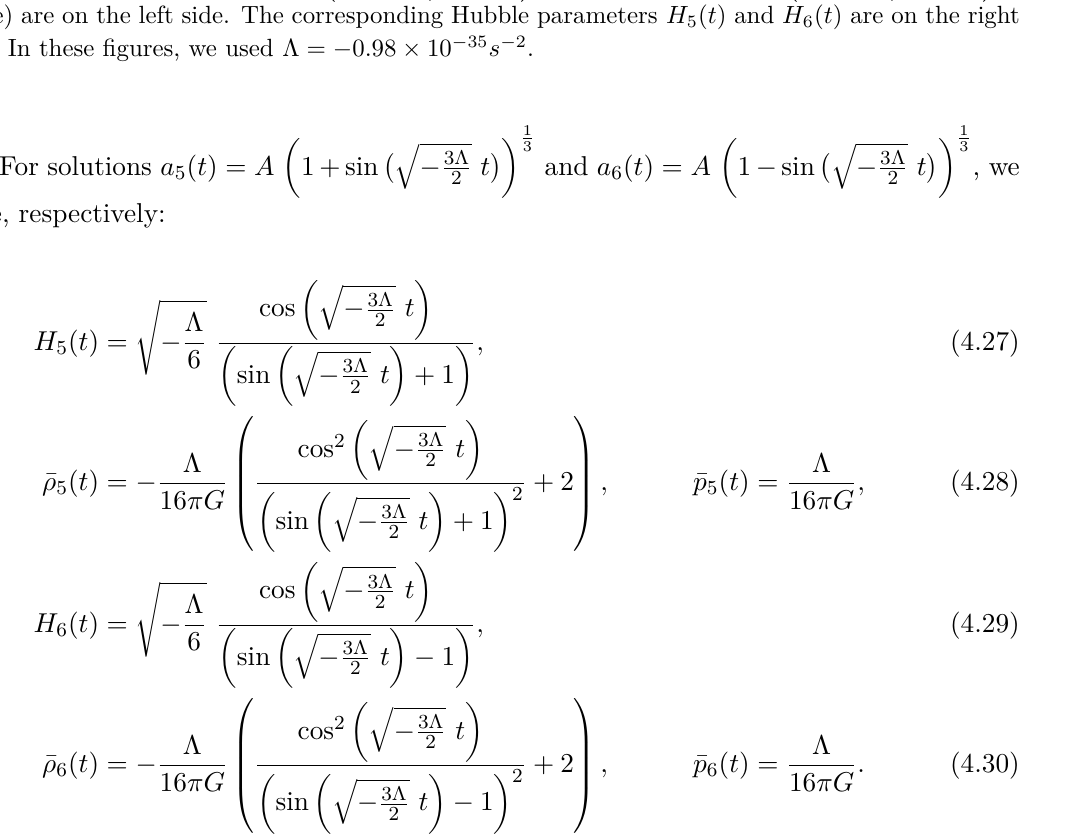
(cid:0)q (cid:16) (cid:1)(cid:17) 1 3 , ( t ) = A 1 − sin − 3Λ t 6 2 ( t ) and H ( t ) are on the right 5 6